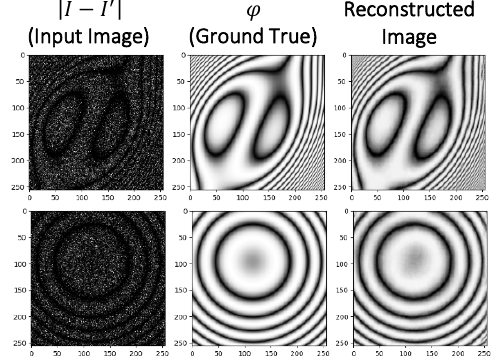
Fig. 1. Results of the Neural Network on a sample of Test